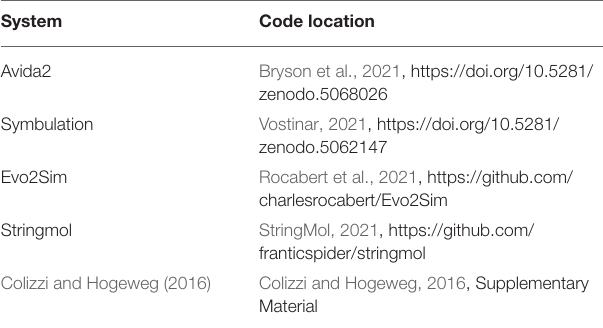
TABLE 3 | The locations of available digital evolution software that supports